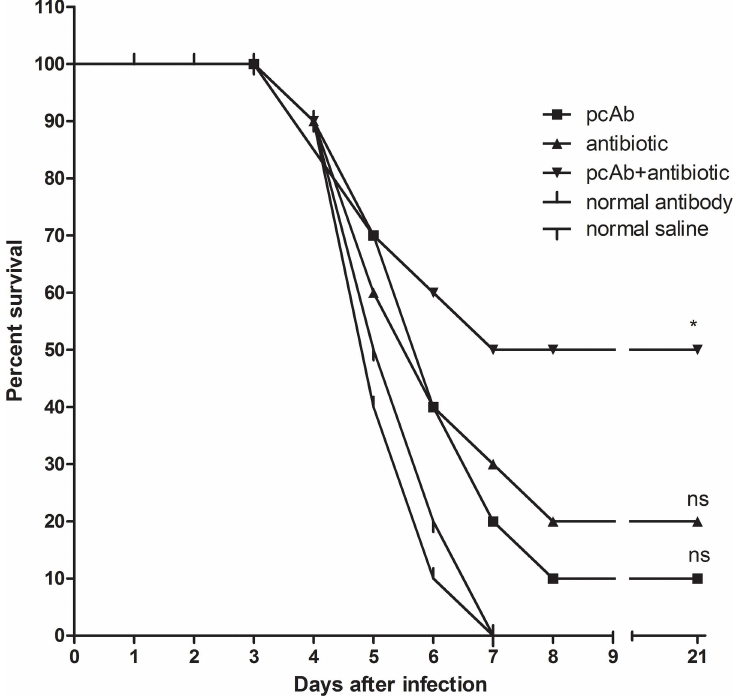
Fig 3. Survival of hamsters treated in the late leptospirosis. Efficacy of IgG-pcAb (16 mg/kg), antibiotic (doxycycline, 5mg/kg) and combination (pcAb plus antibiotic)were evaluatedin treating acute and late homologous (56601)leptospirosis. Survivaldifferencesbetweenstudy groups were comparedusing the log- rank test. * P < 0.05vs. the control